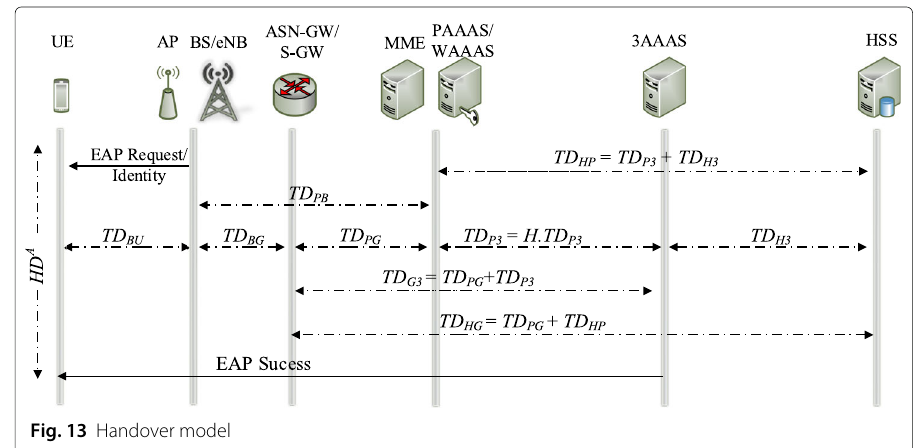
Fig. 13 Handover